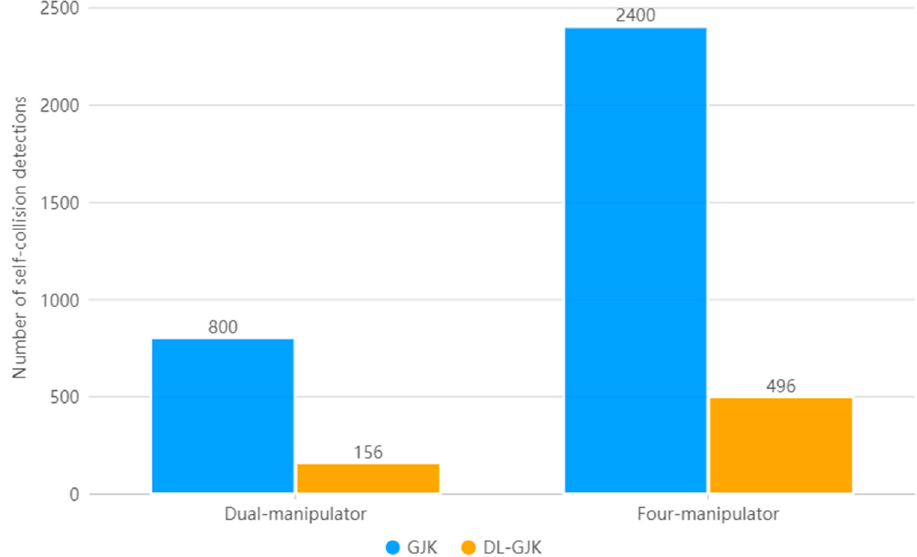
Figure 18. Number of detections for manipulator working path.